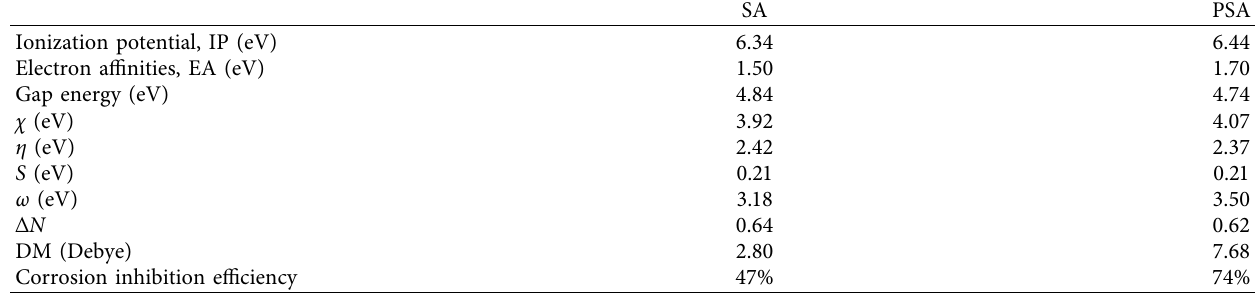
Table 7: Electronic and molecular properties of SA and PSA calculated in PCM model at the B3LYP/6-31G (d) level of theory.